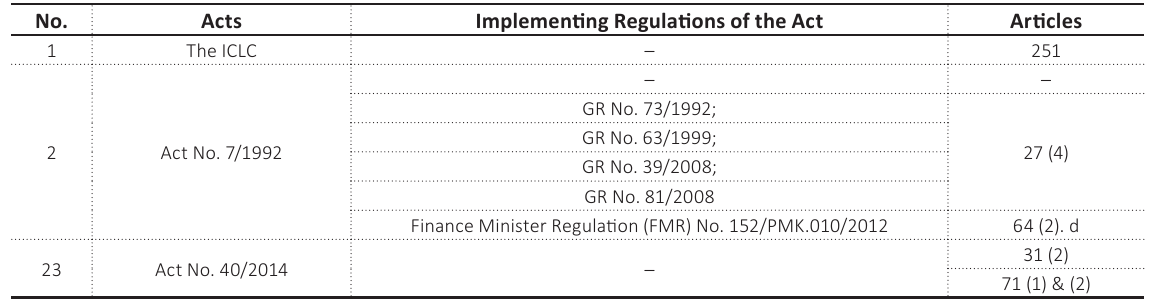
Table 1. Highest good faith regulation in insurance regulation